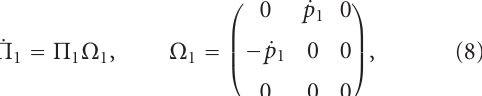
Figure 1: A pair of robot fingers grasping a 3D rigid object with smooth surfaces.